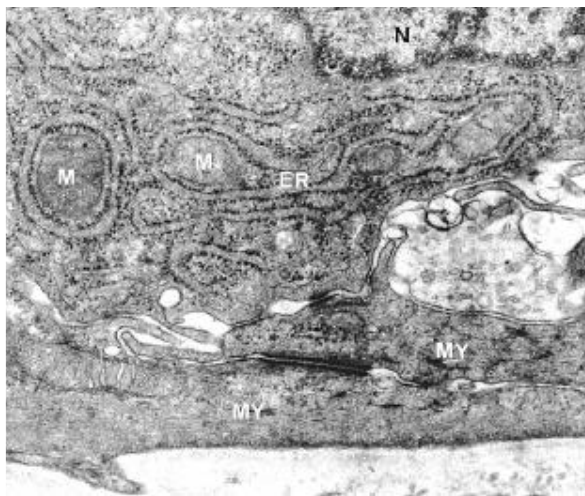
FIGURE 2- Base of mucous acinar cell and myoepithelial cell prolongation’s. Observe: nucleus(N), endoplasmic reticulum(ER), mitochondria(M) and myoepithelial cell prolongations(My) exhibiting myofilaments. x 38,500.